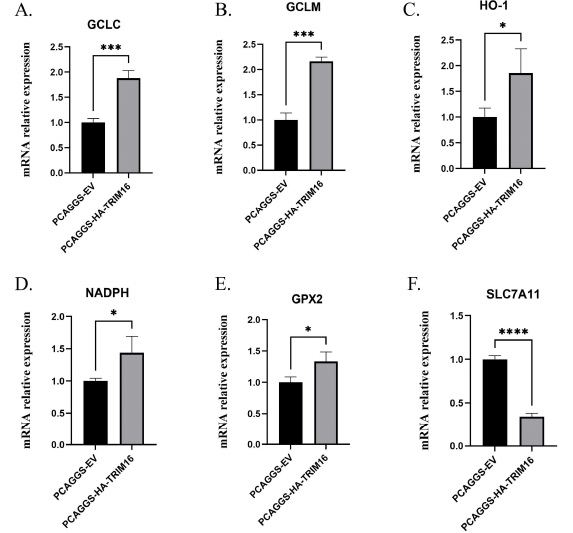
Figure 4. Relative expression of antioxidant genes after overexpression of TRIM16 in A549 cells for 24 h. At 24 hpi, RNA was extracted from A549. The mRNA expression levels were analyzed by qPCR. GAPDH was used as loading control. The relative expression of ( A ) GCLC, ( B ) GCLM, ( C ) HO-1, ( D ) NADPH, ( E ) GPX2, ( F ) SLC7A11 were detected by real-time RT-PCR. All data were expressed as means ± SD, the Student’s t -test was used to analyze the differences. (* p < 0.05, *** p < 0.001 and **** p < 0.0001).